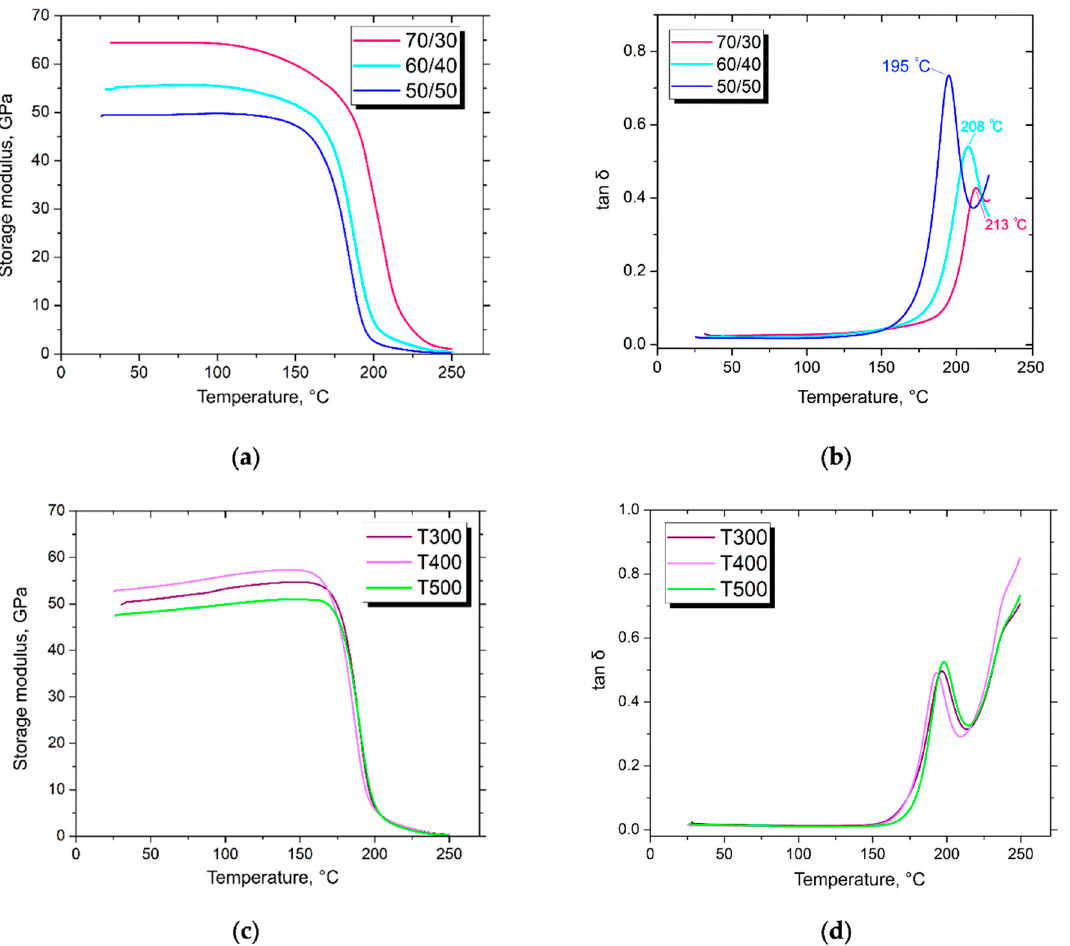
Figure 12. Typical DMA curves of composites reinforced with ( a , b ) initial CF, and ( c , d ) modified CF (composites reinforced with modified fibers containing 50 wt. % of CF).